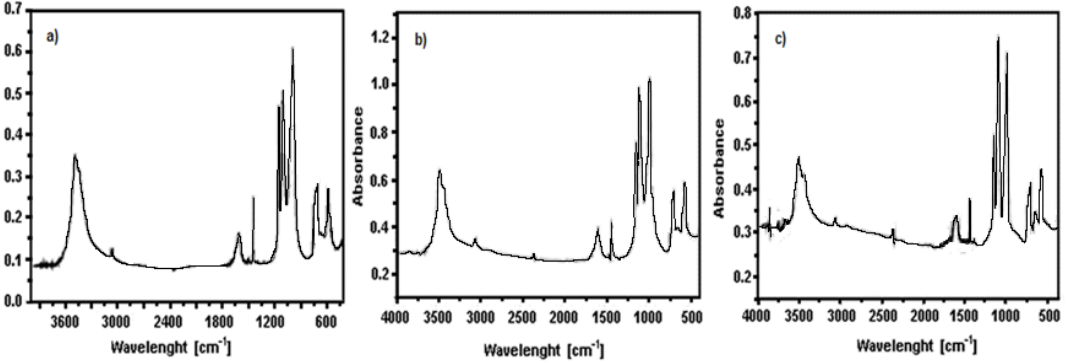
Figure 1. FT-IR spectra of precursors: ( a ) Fe 0.9 Mn 0.1 (C 6 H 5 PO 3 )(H 2 O) ( P1 ); and ( b ) Fe[(C 6 H 5 PO 3 )H 2 O] ( P2 ) and ( c ) Mn(C 6 H 5 PO 3 )(H 2 O) ( P3 ).